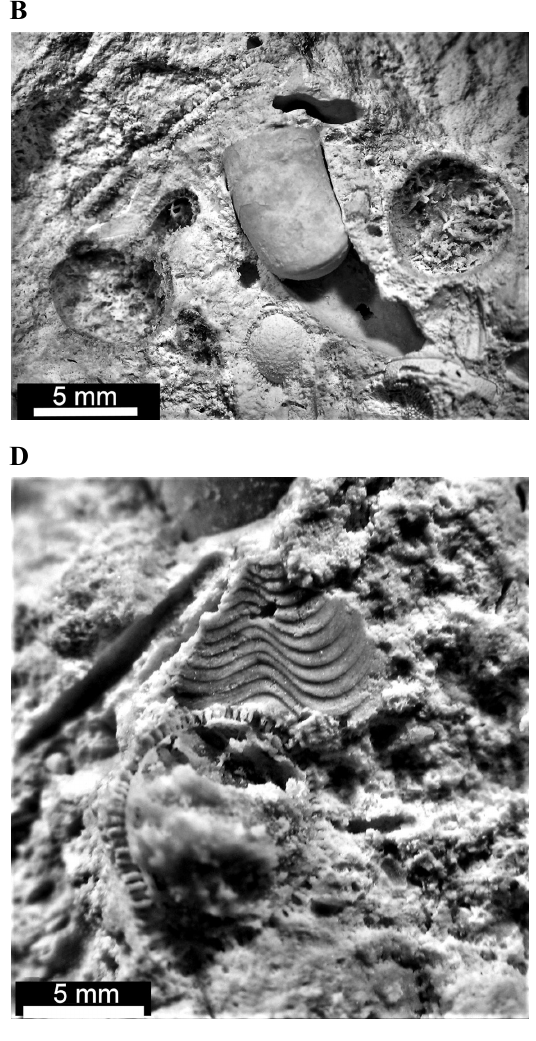
Fig. 10. A , fragment of a boulder showing an assembly of fossils characteristic of type 1. Arrows: A, Apidium sp. [‘claviformis’]; H, Hoeegonites sp. [‘elongata’]. RGM 1317647, Wilsum. B – D , details of the boulder depicted in Fig. 10A: B, left and right: two specimens of Apidium sp. [‘claviformis’], in the specimen to the right laterals are discernible; top left: Hoeegonites sp. [‘elongata’]; centre bottom: Apidium pygmaeum ; centre: undetermined cephalopod. C, top: hypostome of Otarozoum peri ; bottom: Mastopora concava . D, top: sclerite of a machaeridian, presumably Plumulites sp.; bottom: Apidium pygmaeum